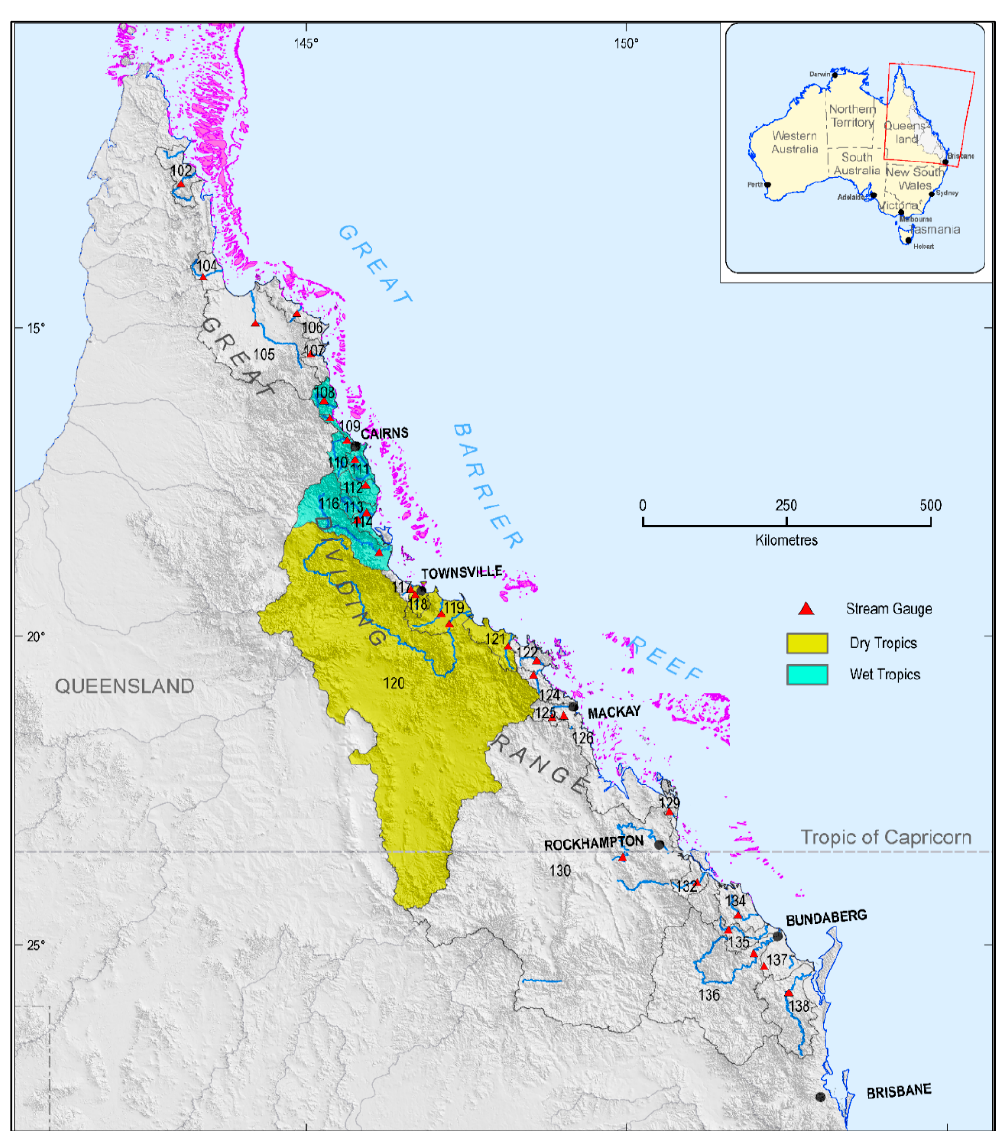
Figure 1. Catchments of the Great Barrier Reef (GBR) lagoon showing major rivers and stream gauges. The numbers on the map represent catchment identification and the catchment name under each identification number is presented in the results section.